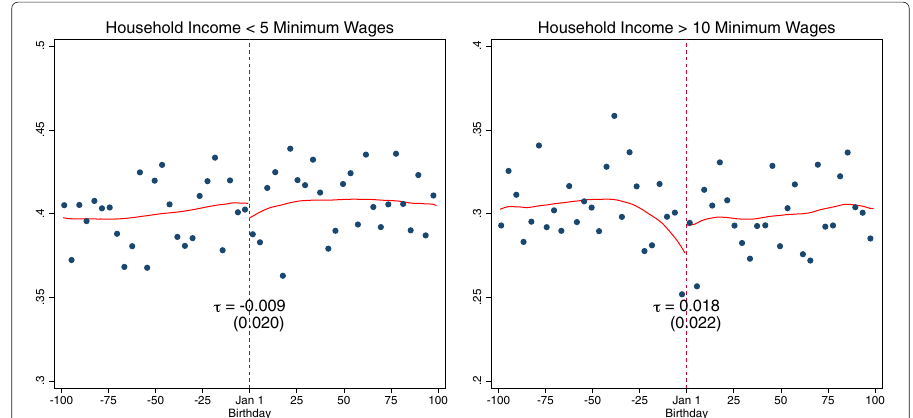
during their primary school years, while those born on December 31 are more likely to be the youngest. Using data from PNAD, we investigate what happened to those cohorts of college candidates when they were 6 years old.